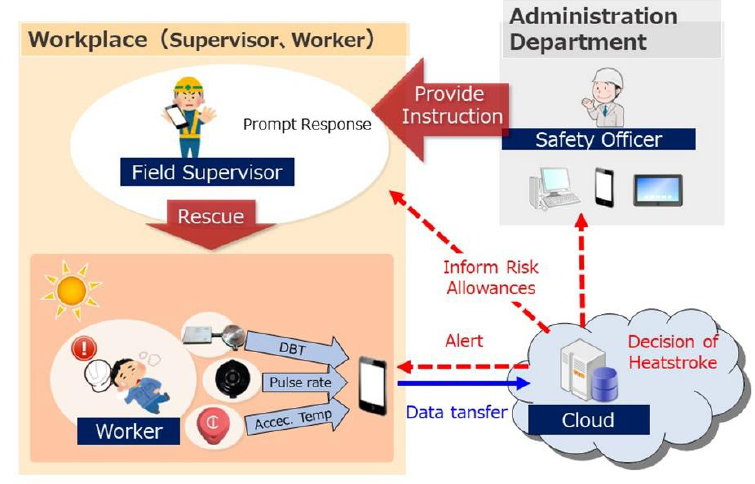
Figure 1. The IoT heatstroke-prevention system.